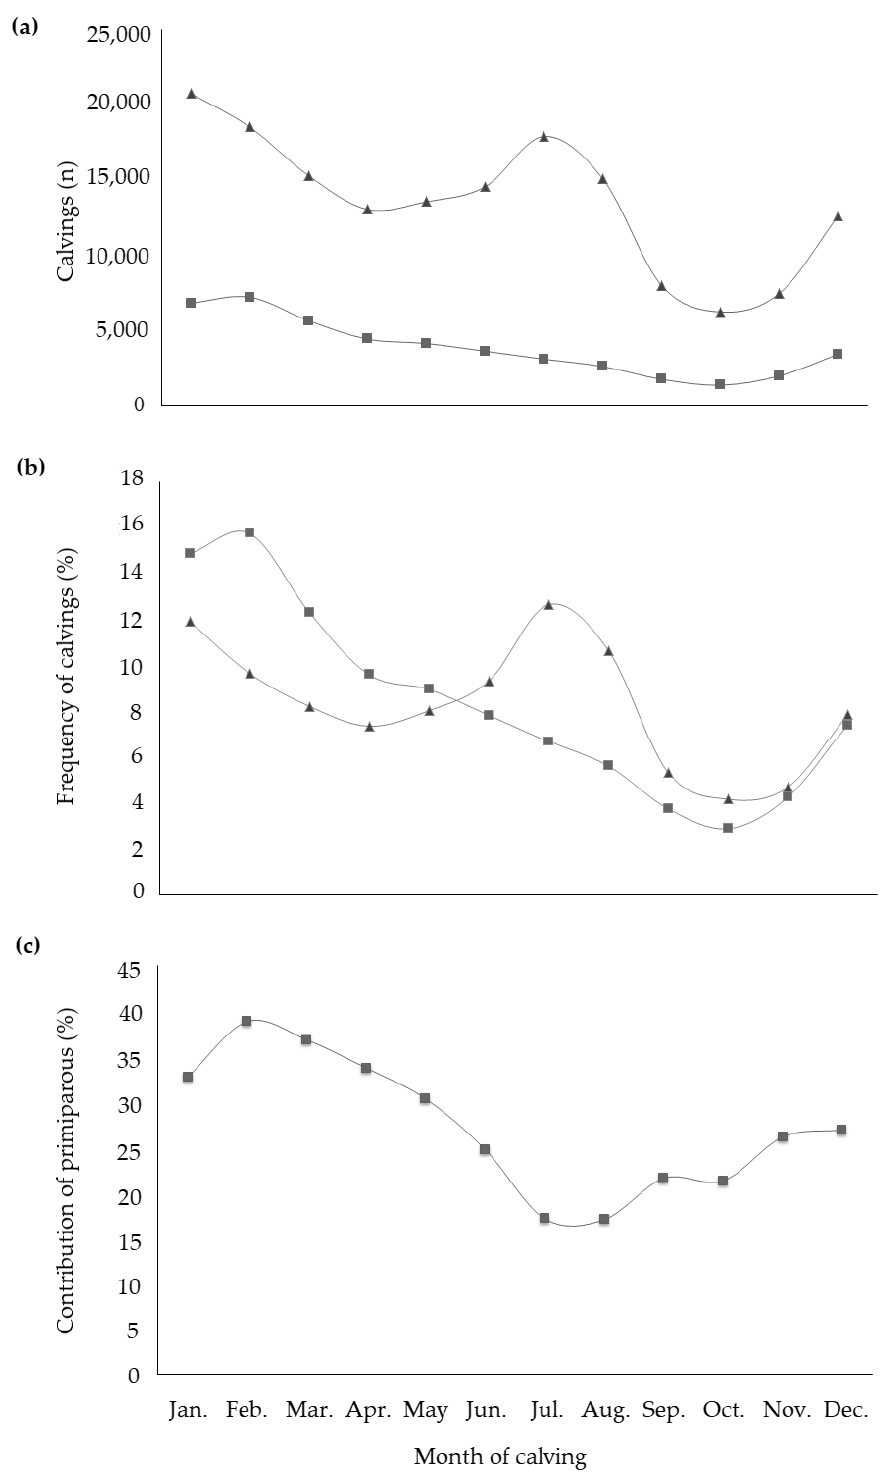
Figure 1. Distribution ( a ) and frequency ( b ) of calvings within the year in primiparous ( ■ ) and multiparous ( ▲ ) buffaloes, with the contribution ( c ) of primiparous to the total calvings of each month.